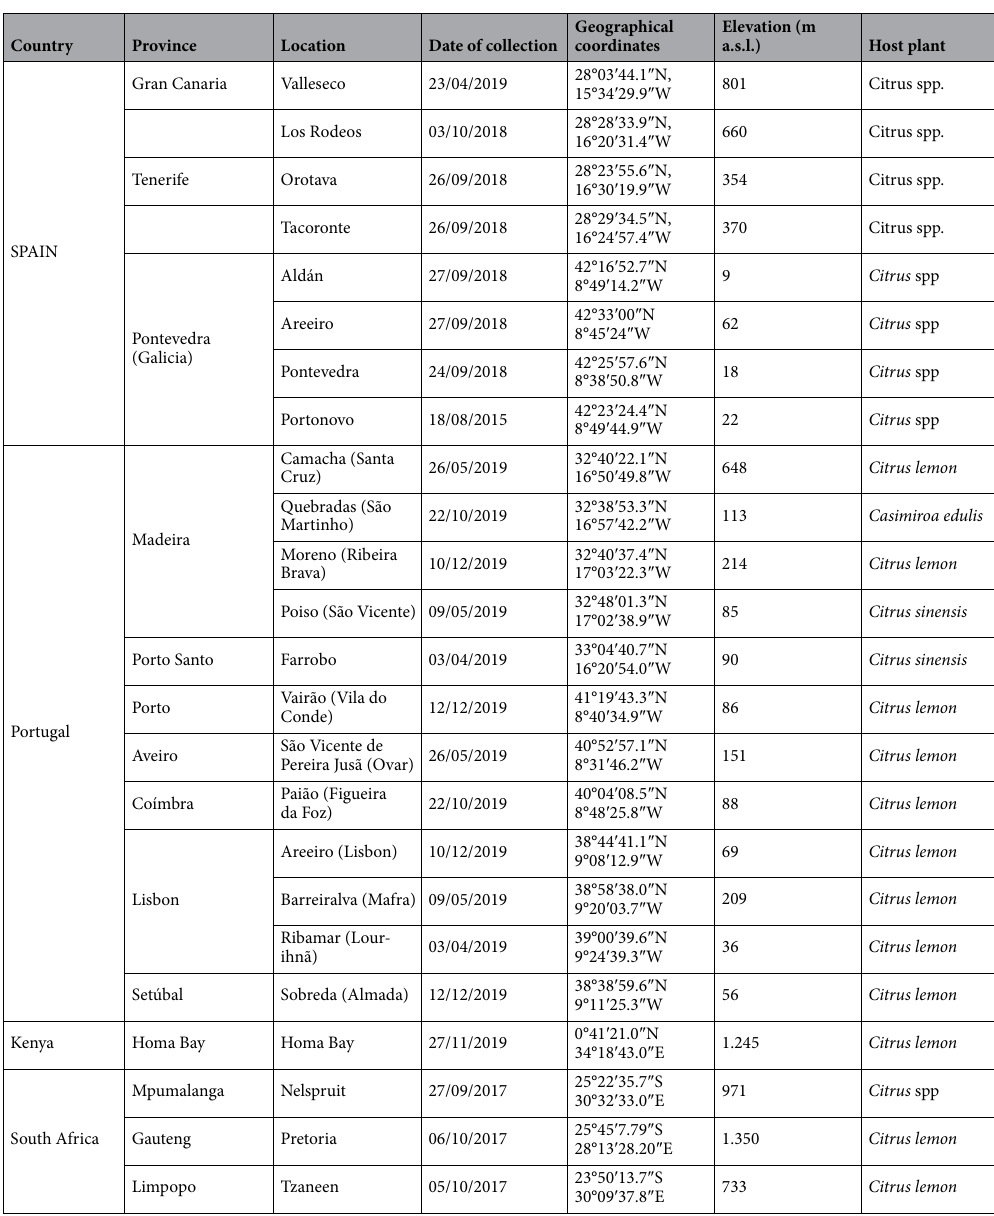
Table 2. Collection data of T. erytreae